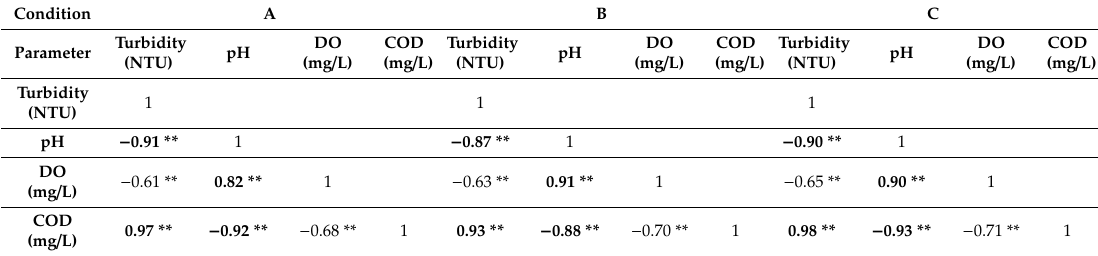
Table 4. Correlation on water quality attributes (turbidity, pH, DO and